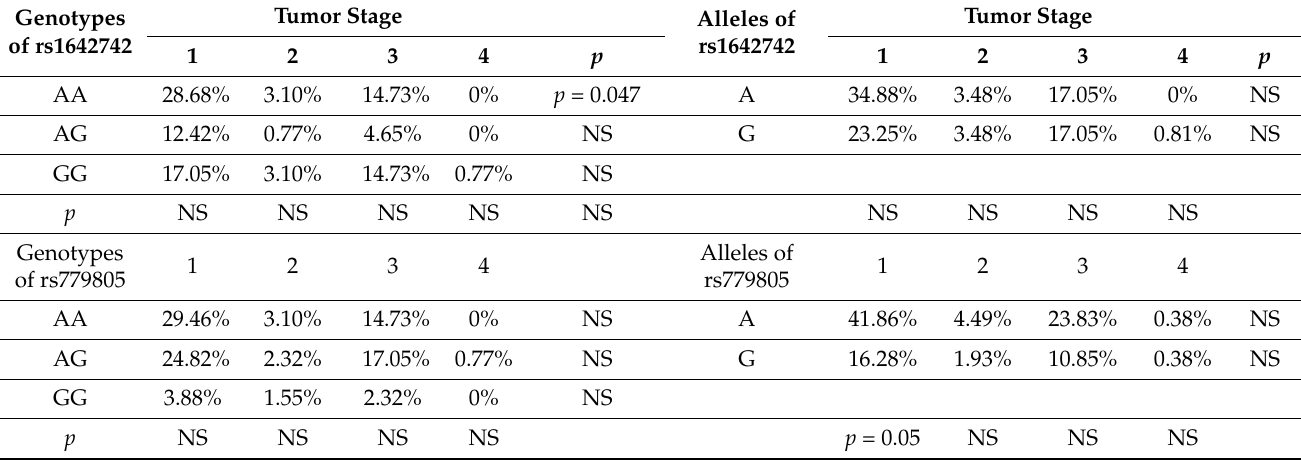
Table 5. Associations of the VHL polymorphisms with pathologic tumor (T) stage of renal carcinoma.